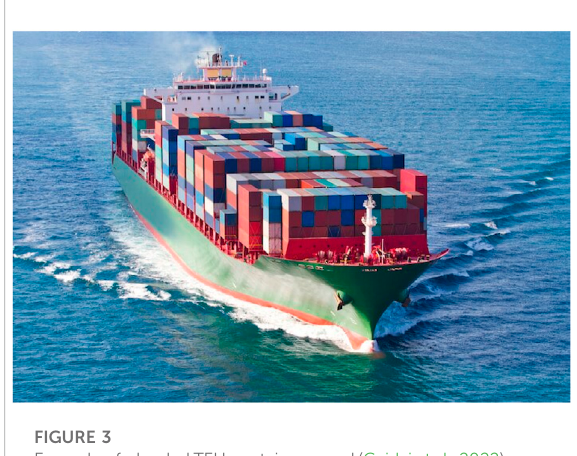
FIGURE 2 Comparison of deconvolution methods (solid blue), analytic (green), and NG (dashed blue). The MC-simulated response is indicated in red (*).